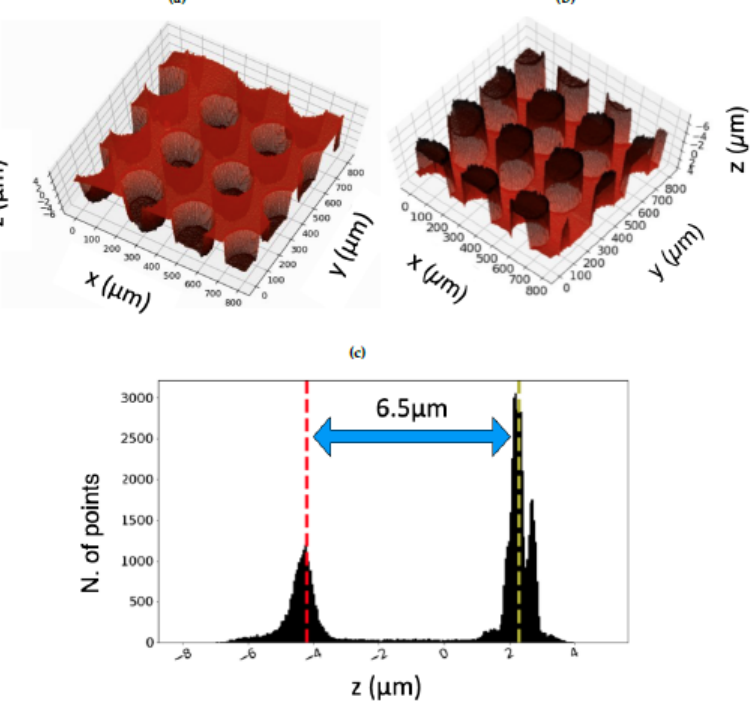
Figure 6. 3D rendering of ( a ) Fishbone texture and ( b ) its bottom. In ( c ), the histogram presenting the distribution of the height levels in ( a ) is shown. The distance between two peaks, being equal to 6.5 µ m, represents the depth of each